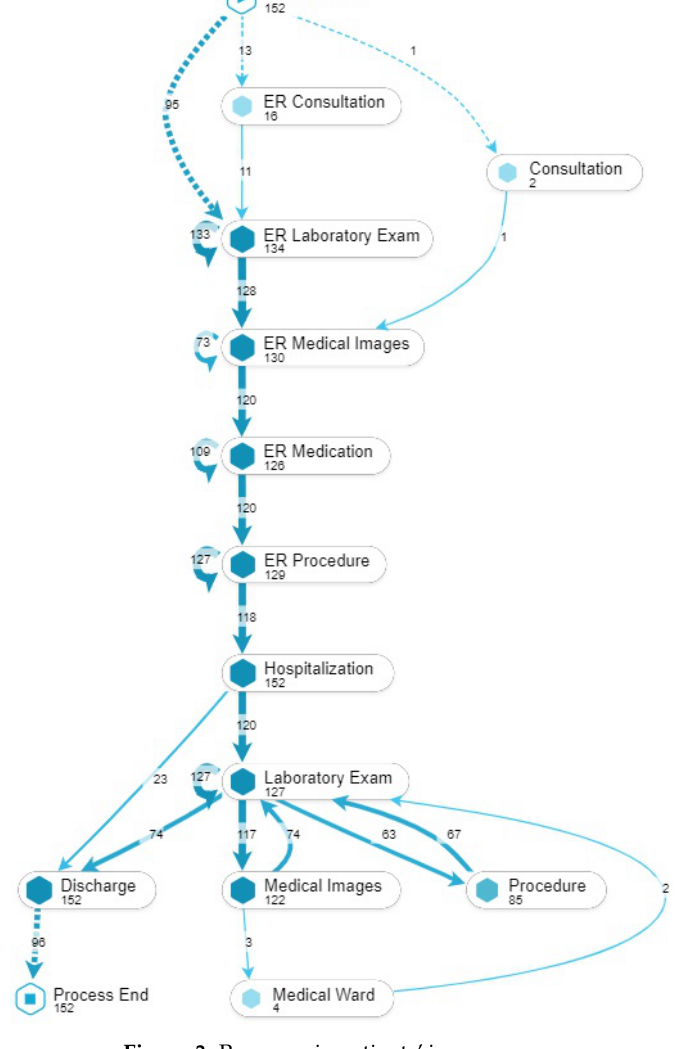
Figure 3. Pneumonia patients’ journey map.